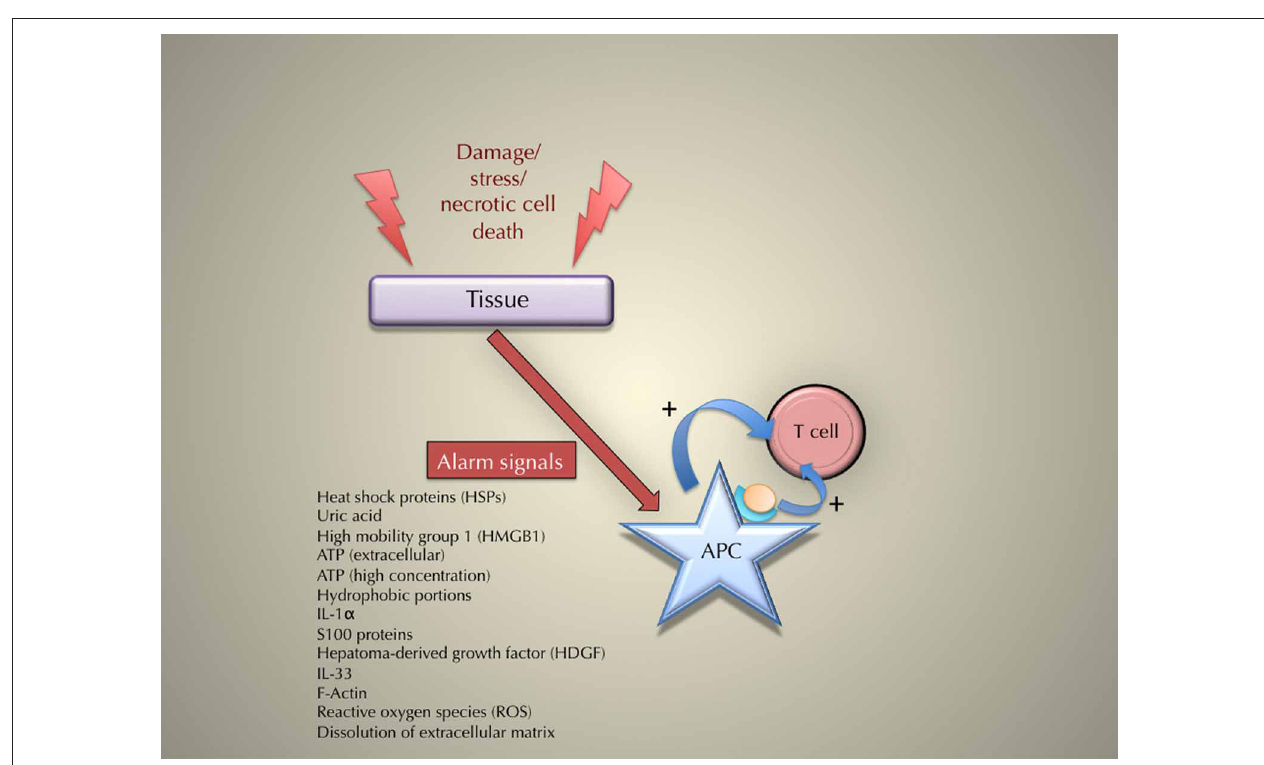
FIGURE 1 | The principle of the triggering of an immune response according to the danger (or “damage”) theory.